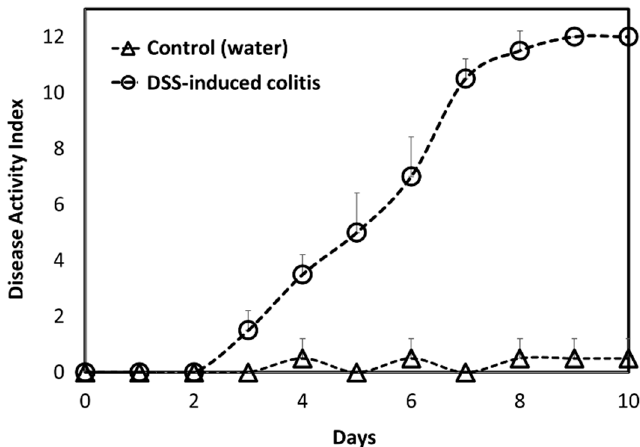
Figure 5. Disease activity index (DAI) score assessed daily for each animal in the dextrane sulphate sodium (DSS)-induced colitis rats ( ○ ) vs. healthy animals ( ∆ ) for 10 days. Results are expressed as mean ± SD ( n = 2).